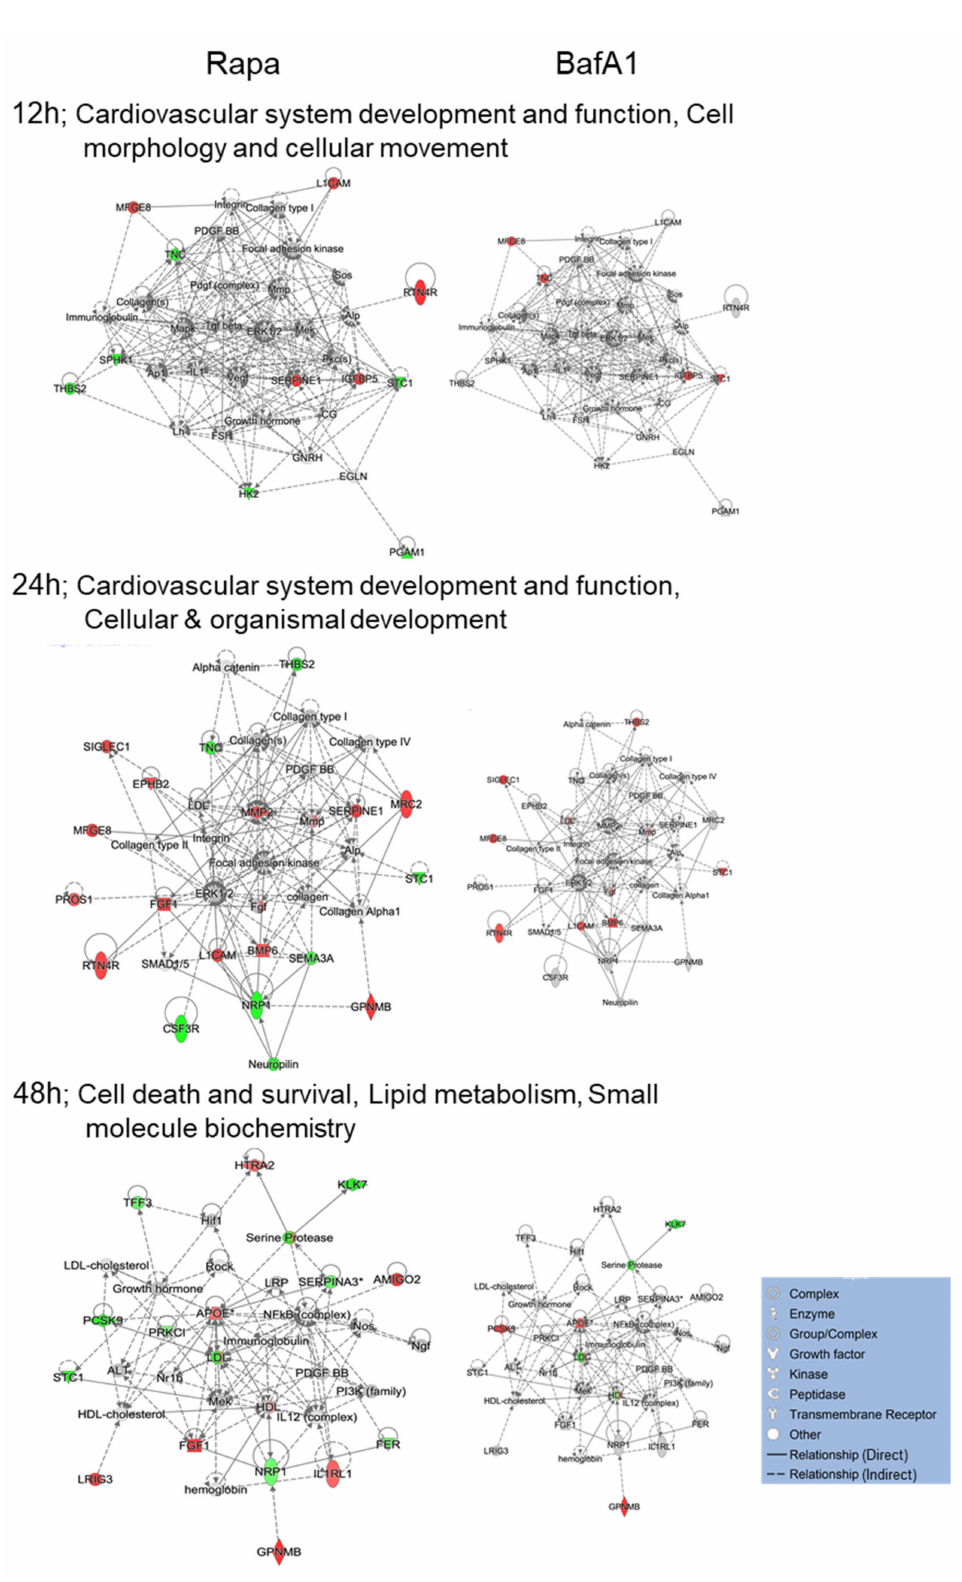
Figure 5. IPA-determined top cellular Networks affected by 200 nM rapamycin (Rapa). Top Rapa-affected network at each time (left), with 2 nM BafA1 data overlaid (right). The top BafA1-a ff ected networks are shown in Figure 4. Red proteins are significantly up-regulated; green are down-regulated; grey proteins were not significantly dysregulated; white proteins are part of the network but not covered by the SOMA panel. Protein types indicated in